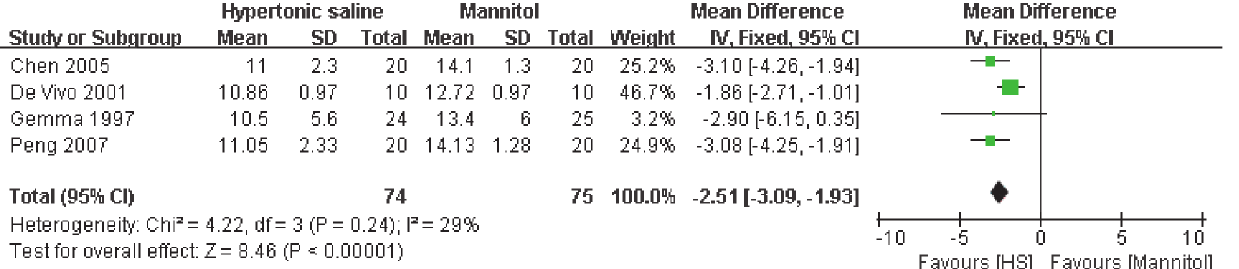
Fig 3. Maximal intraoperative ICP before opening dura in HS and mannitol groups. IV: Inverse Variance.